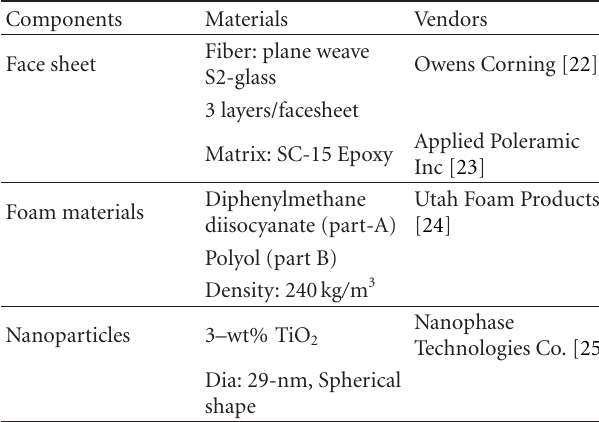
Table 1: Various materials used for making sandwich with nano- phased